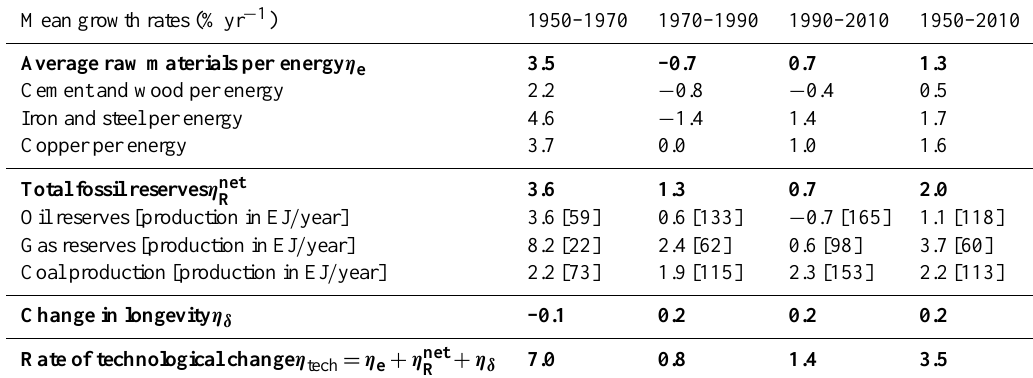
Table 2. Components of technological change expressed as 20- and 60-year averages of growth rates. Bold numbers represent weighted averages. See Section 3.3 and Appendix B for details.